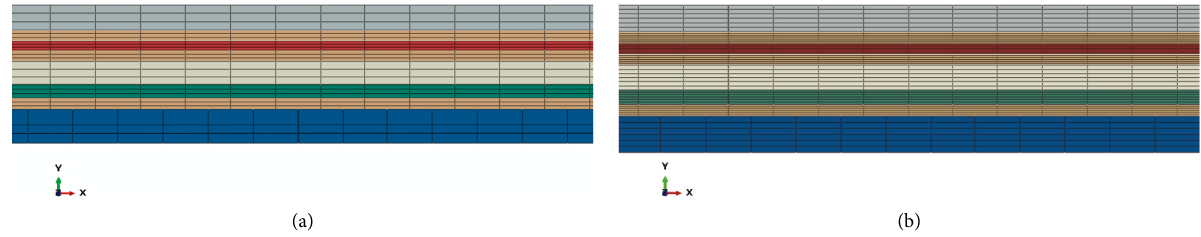
Figure 4: Part of the mesh in the panel: (a) default mesh and (b) refined mesh.